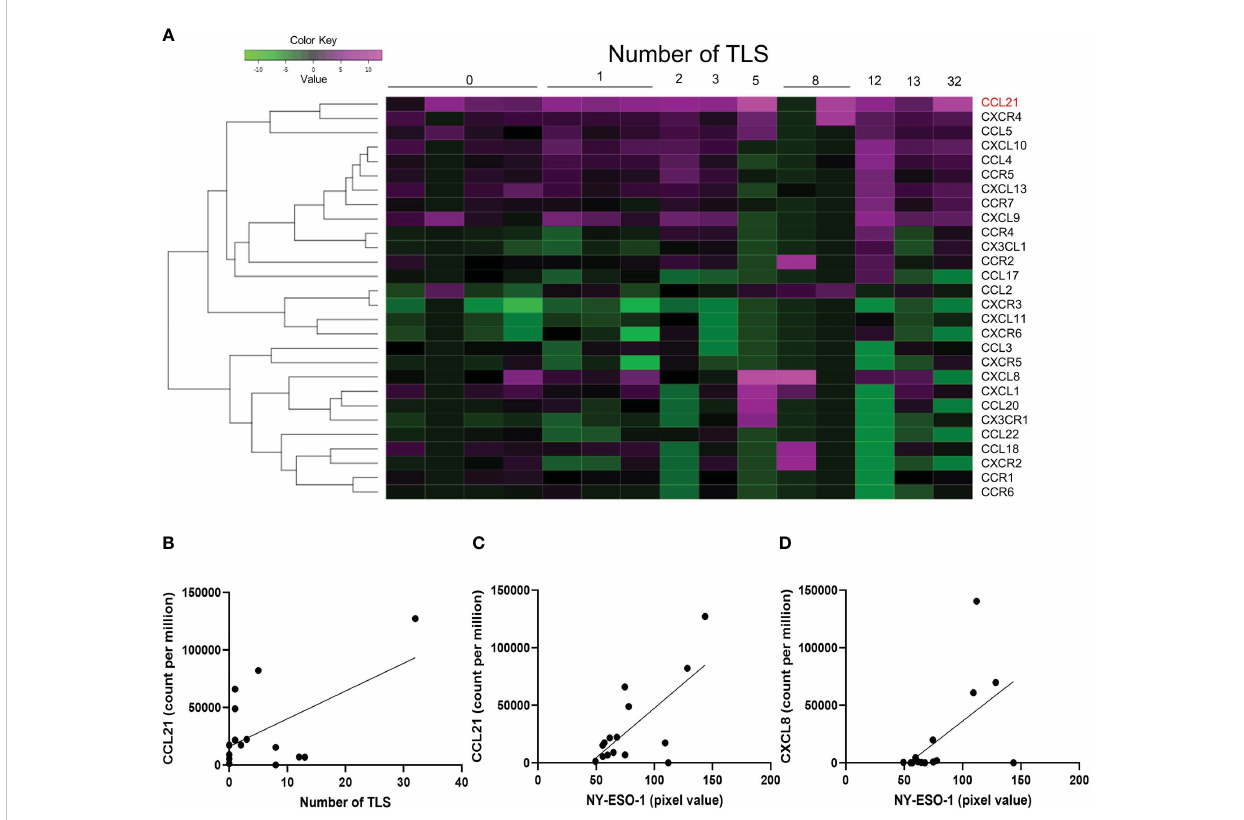
FIGURE 4 Chemokines associated with NY-ESO-1 and XAGE-1 expression. The heatmap shows the number of TLS formations and the expression of chemokines. 28 chemokines included in the Oncomine Immune Response Research Assay were analyzed (A) . Linear regression analysis showed that only CCL21 was correlated with the number of TLS (p-value=0.0273) (B) . Expression of NY-ESO-1 was correlated with CCL21 (p-value=0.0030) (C) and CXCL8 (p-value=0.0242) (D)